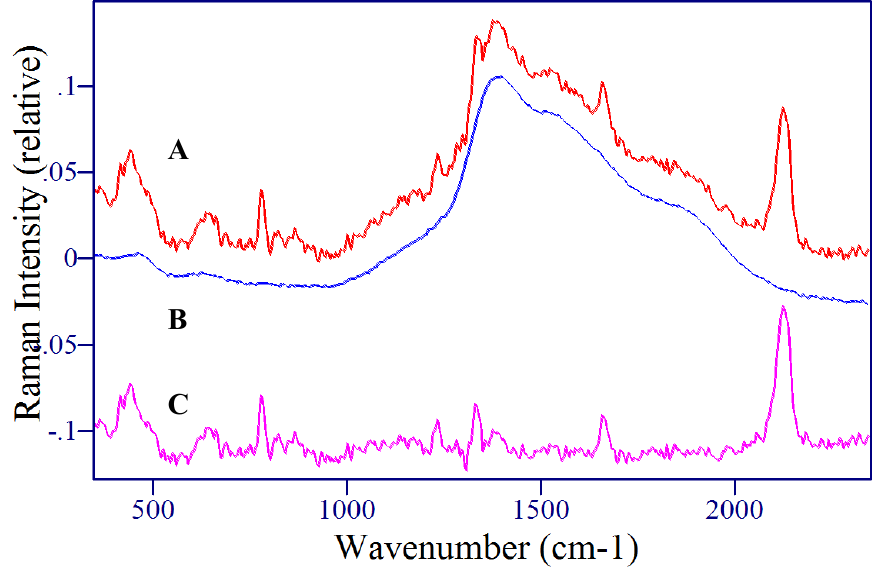
Figure 14. 2 μ g/mL 5-FU A) before and C) after subtraction of B) the glass capillary background. Conditions: HCl washed silver-doped sol-gel capillaries, 100 mW of 785 nm,